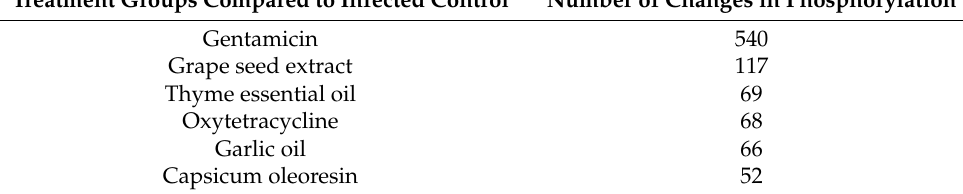
Table 2. Number of changes in phosphorylated proteins of treated groups in comparison to infected control ( p ≤ 0.05).